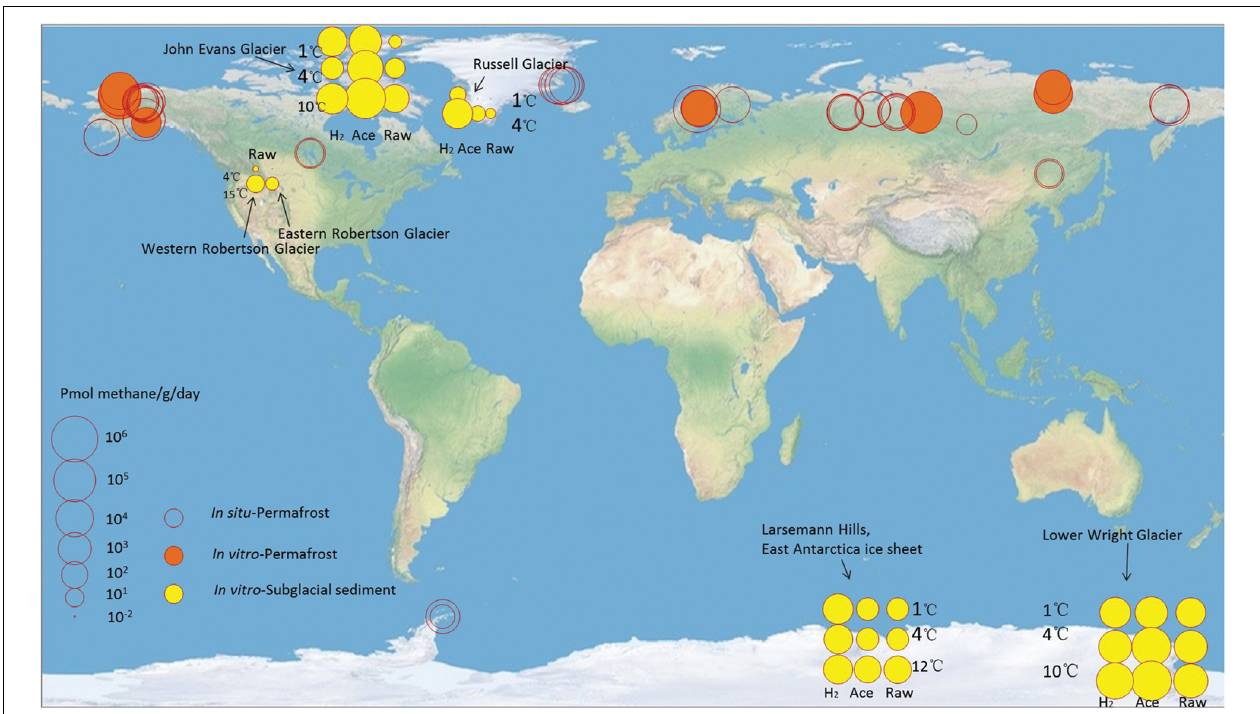
FIGURE 5 | Methane production rate ((pmol/g)/day) in subglacial sediment and permafrost. For the subglacial sediment, the ex situ incubation temperature and the substrate (H 2 : H 2 supplied; Ace: acetate supplied; Raw: no additional substrate supplied) concentrations were obtained from corresponding experiments. For the permafrost sediment, the ex situ data were obtained from corresponding experiments. The in situ data were obtained from the in situ static chambers. The in situ flux values were converted from (mg/m 2 )/day to (pmol/g)/day according to the depth of active layer and 2 g/cm 3 density of soils. Data were derived from this study and references (Supplementary Table